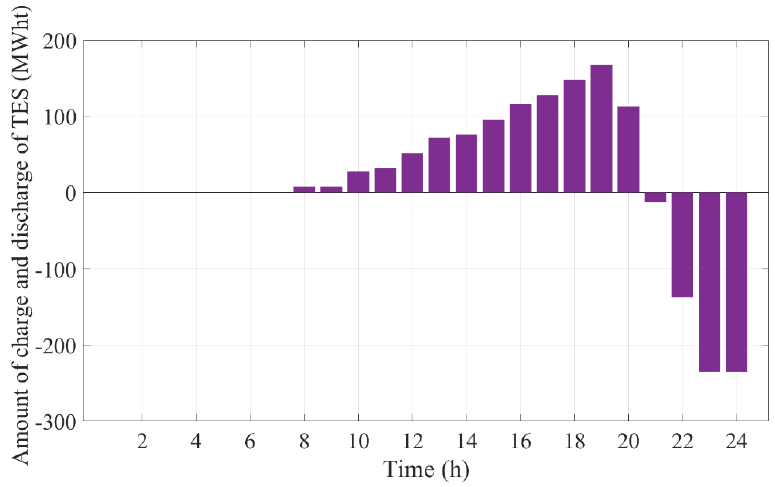
Figure 13. Amounts of charge and discharge of TES in the CSP plant associated with case 4.